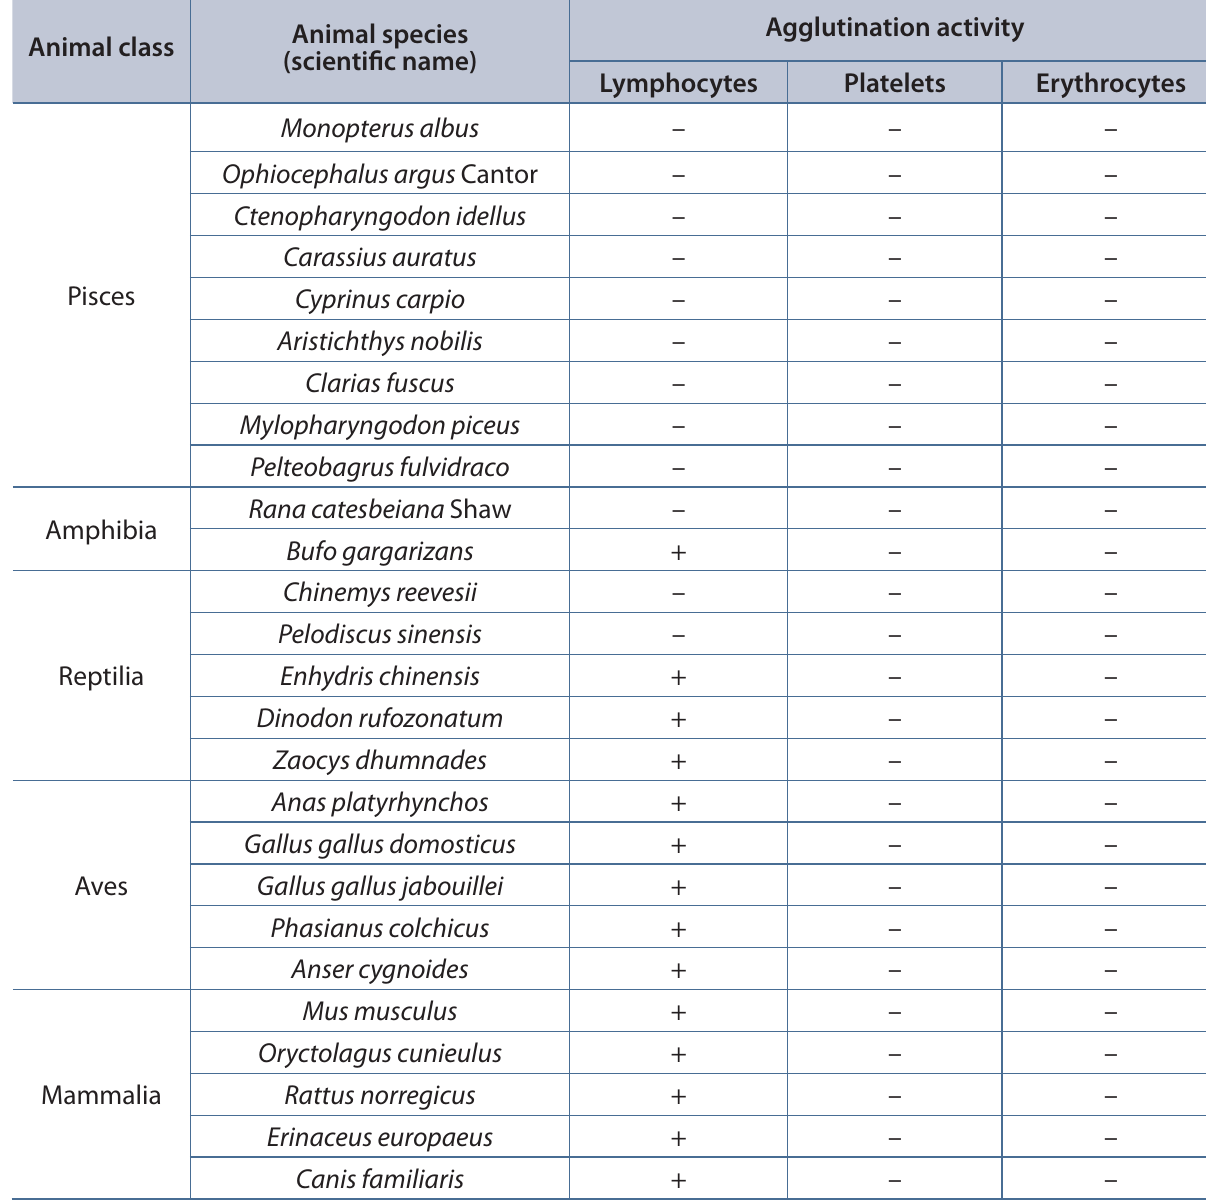
Table 2. Agglutination activities of acutolysin C in different animal lymphocytes, erythrocytes and platelets Animal